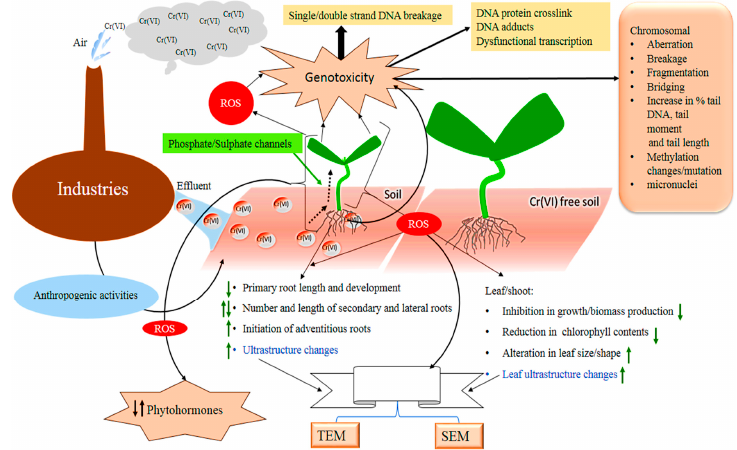
Figure 1. A functional model for the release, accumulation, and toxicity in plants. Cr is released from/through the industrial processes and anthropogenic activities in the soil. The model also visualizes the uptake of Cr by the plant roots, translocation to the shoots. The Cr-induced morphological, physiological, biochemical, molecular, hormonal, and ultrastructural changes in plants are also summarized in the model.